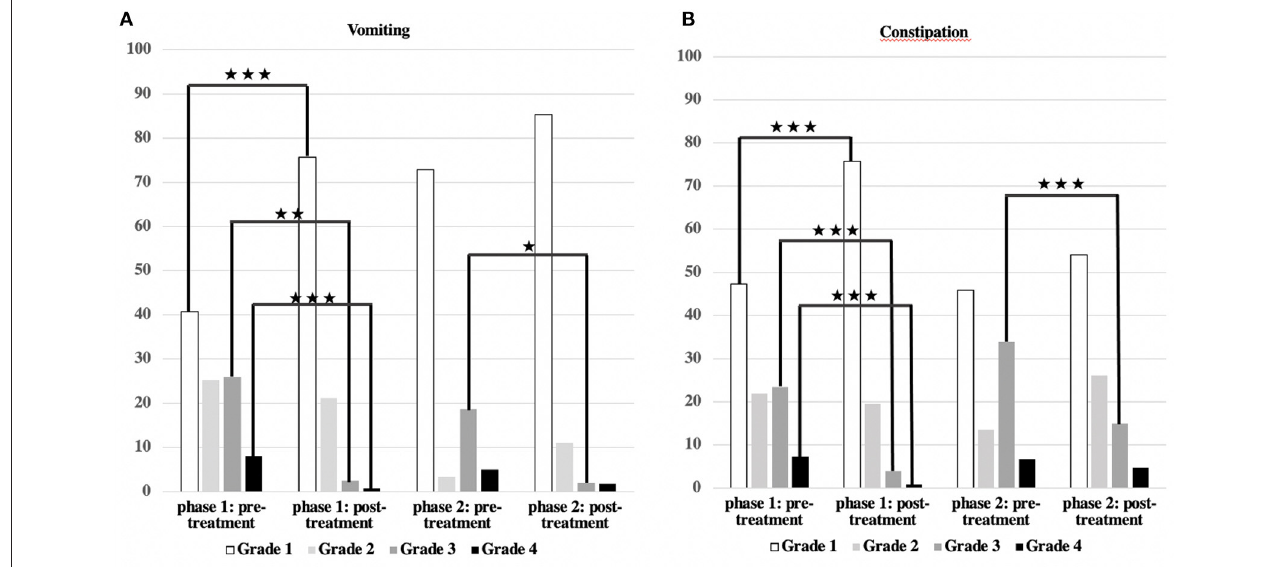
FIGURE 4 | Severity of vomiting and constipation/effect of treatment. (A,B) The main symptoms, vomiting, and constipation, could be significantly reduced in both groups (*** p < 0.001; ** p < 0.01; * p < 0.05).